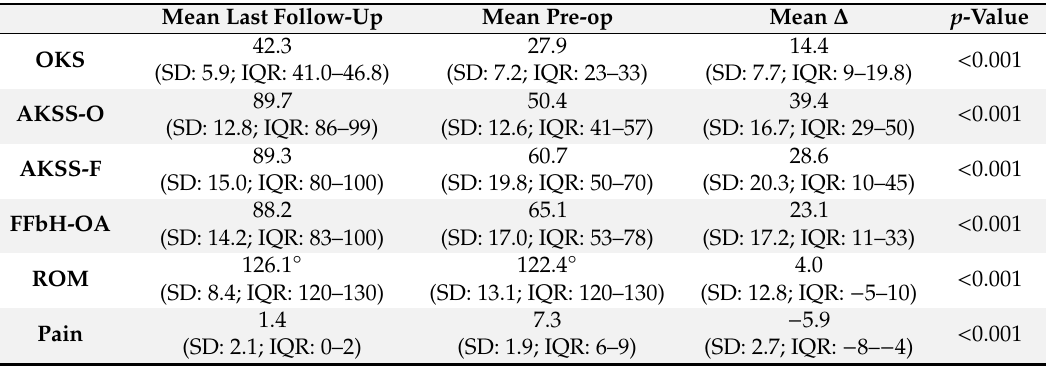
Table 1. Clinical Table 1. Clinical outcome.